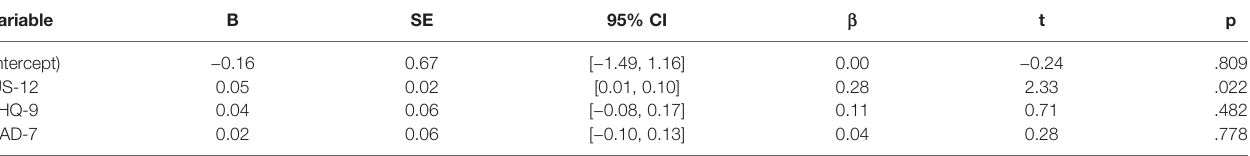
TABLE 4 | Linear regression with IUS-12, PHQ-9, and GAD-7 predicting JGLS.